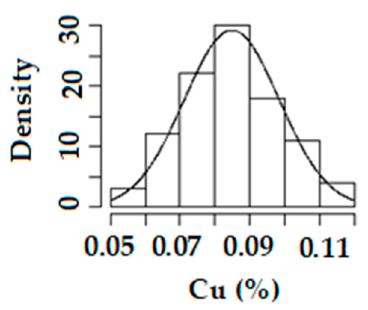
Figure 4. Density plot of Cu concentration in target product A.